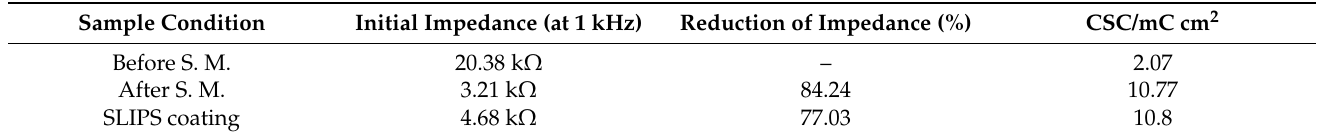
Table 1. Comparison of reduction in impedance at 1 kHz and CSC of the proposed ECoG electrode for various sample conditions.